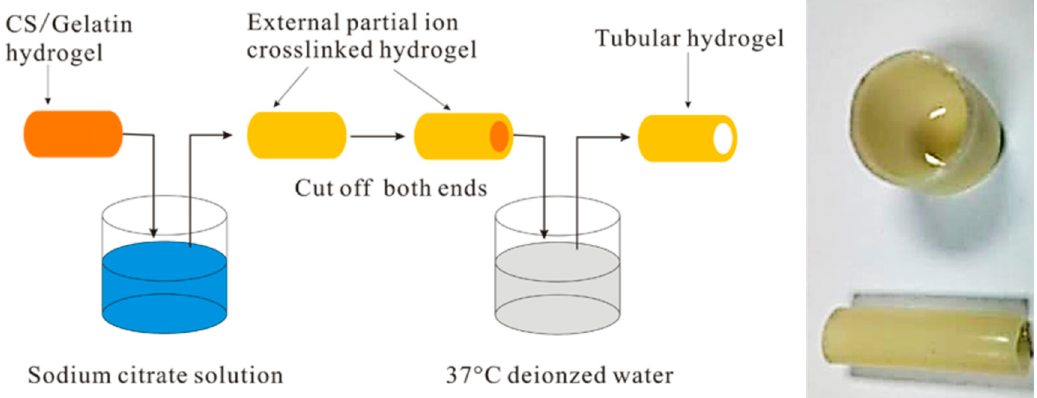
Figure 4. Preparation of hollow structures (e.g., cup and tube) from CS/gelatin hydrogels based on a controllable ion crosslinking process. Reproduced with permission from [113], copyright 2017 Elsevier.